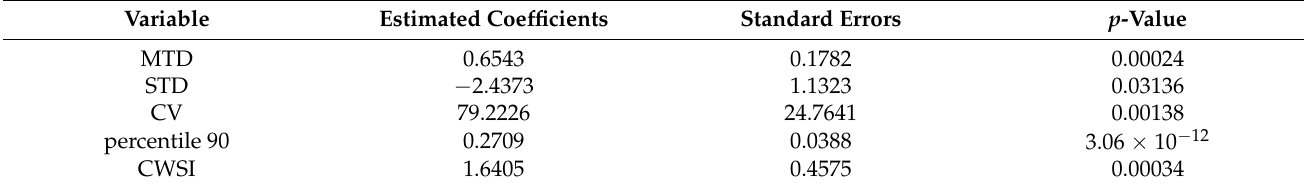
Table 4. Stepwise regression-estimated coefficients, standard errors, and p